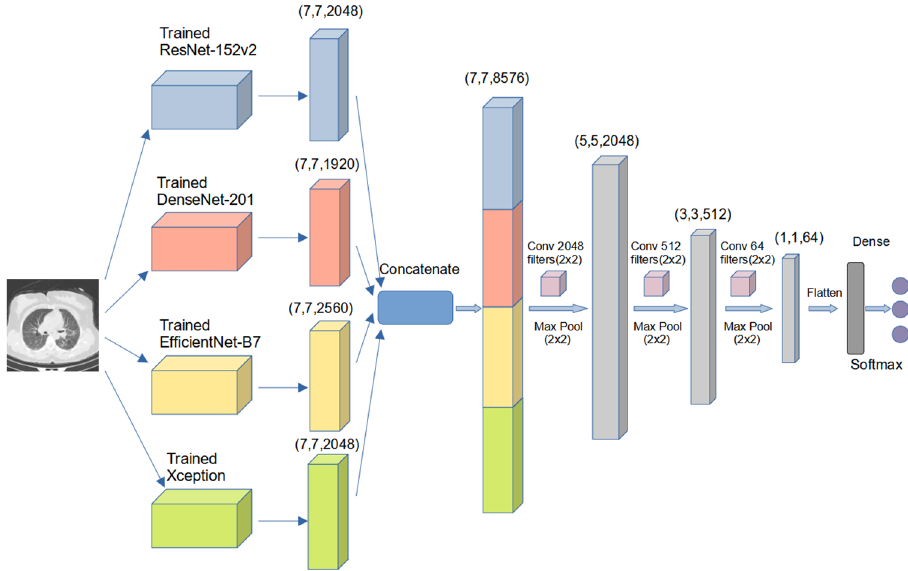
Figure 11. FCN Ensemble CNN Model.